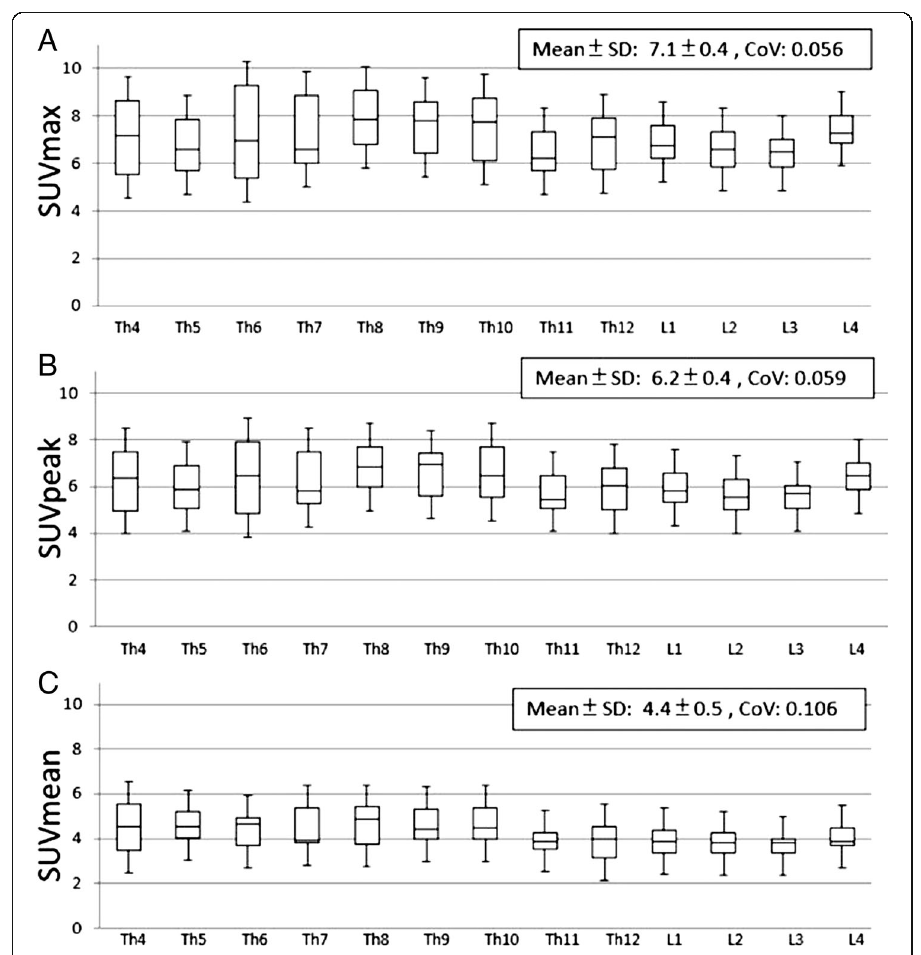
Fig. 4 a – c SUV max normalised to lean body mass has been reported as the best metric of osseous uptake for reducing patient variance (Kaneta et al. 2016). Labels on bottom-axes denote vertebrae. (Figure